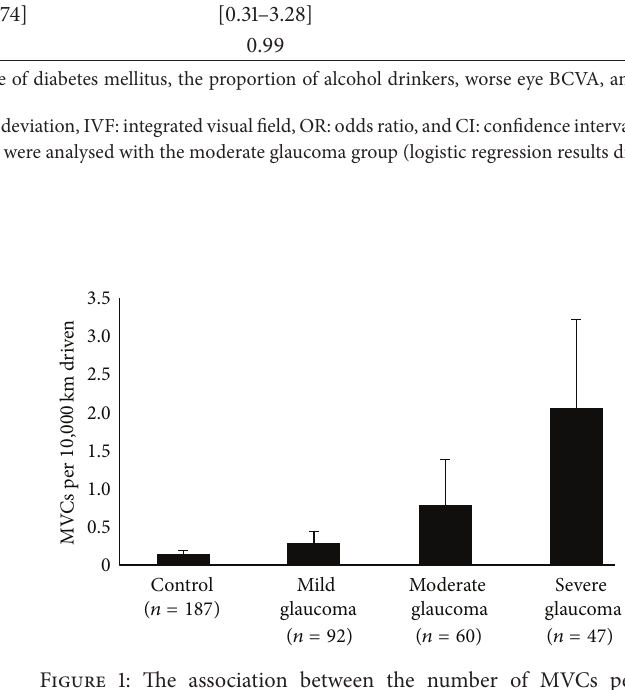
Figure 1: The association between the number of MVCs per 10,000 km driven and glaucoma severity, grouped by worse eye. The number of MVCs went up when the severity of the glaucoma, grouped by worse eye, increased. The trend was statistically signif- icant ( 𝑃 = 0.03 , Jonckheere-Terpstra test). MVC (motor vehicle collision). Error bar: standard